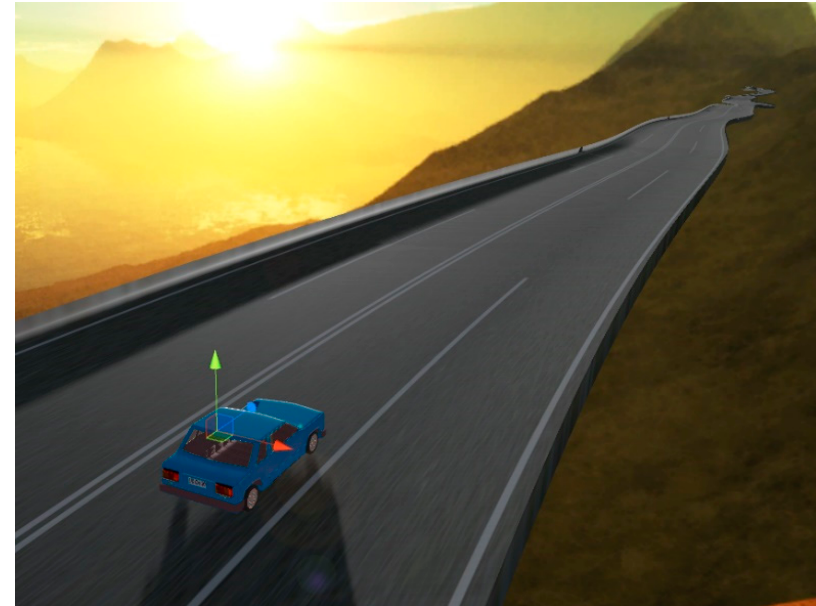
Figure 6. Road generated with cubic splines and random control points.